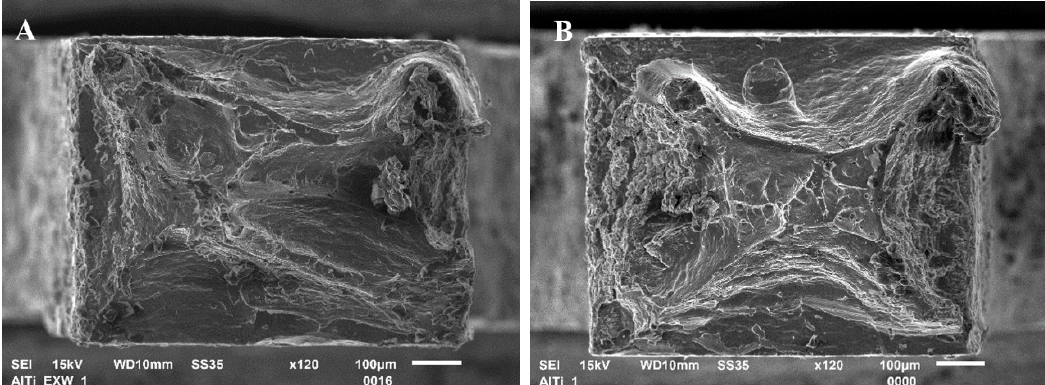
Figure 9. The fracture surface of Al/Ti mini-specimen in the as-welded state ( A ) and after hot-rolling at 400 °C ( B ).